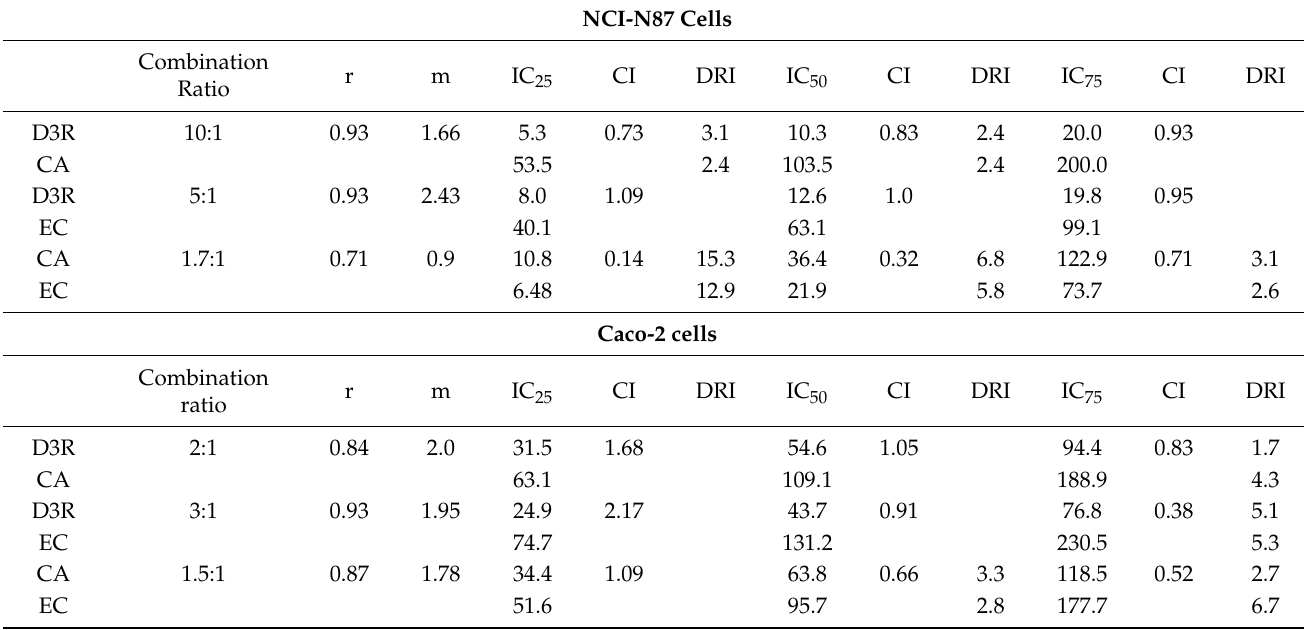
Table 2. Dose-effect parameters (r, m, D m ), combination index (CI), and dose reduction index (DRI) values for combinations of polyphenols towards NCI-N87 and Caco-2 cells proliferation. Dose-effect parameters for individual exposure of polyphenols on NCI-N87 and Caco-2